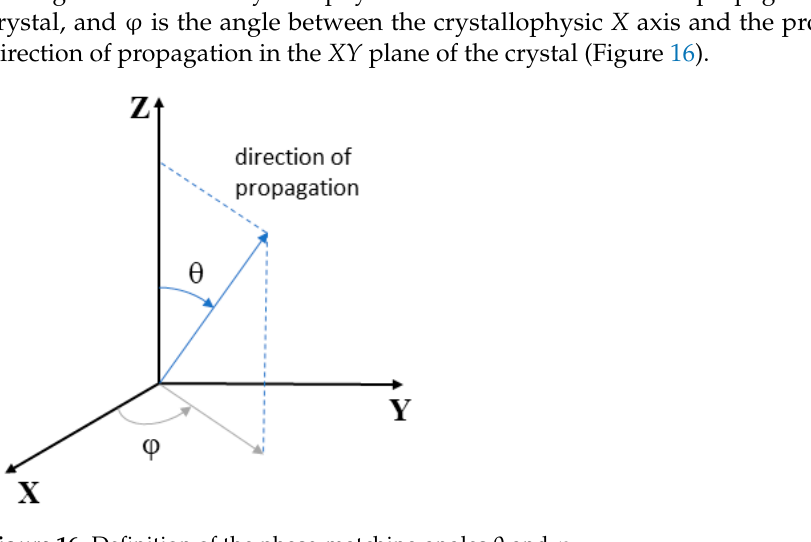
Figure 16. Definition of the phase-matching angles θ and ϕ .